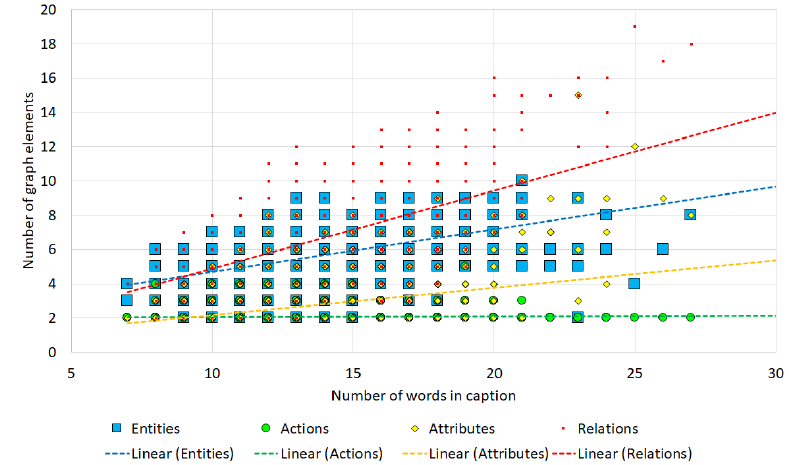
Figure 13. Visualization of the dependency between the number of words and the number of graph elements. The dotted line demonstrates the linear regression of the scatter plot of a specific graph element.